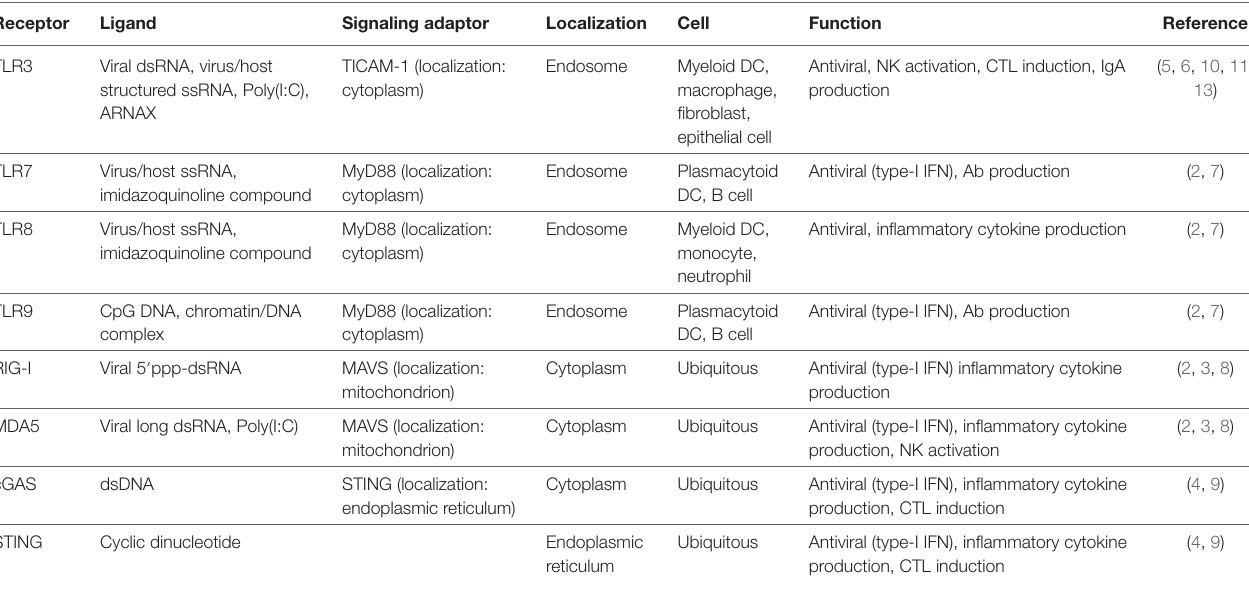
TABLe 1 | Nucleic-acid-sensing innate immune receptors. Receptor Ligand Signaling adaptor Localization Cell Function